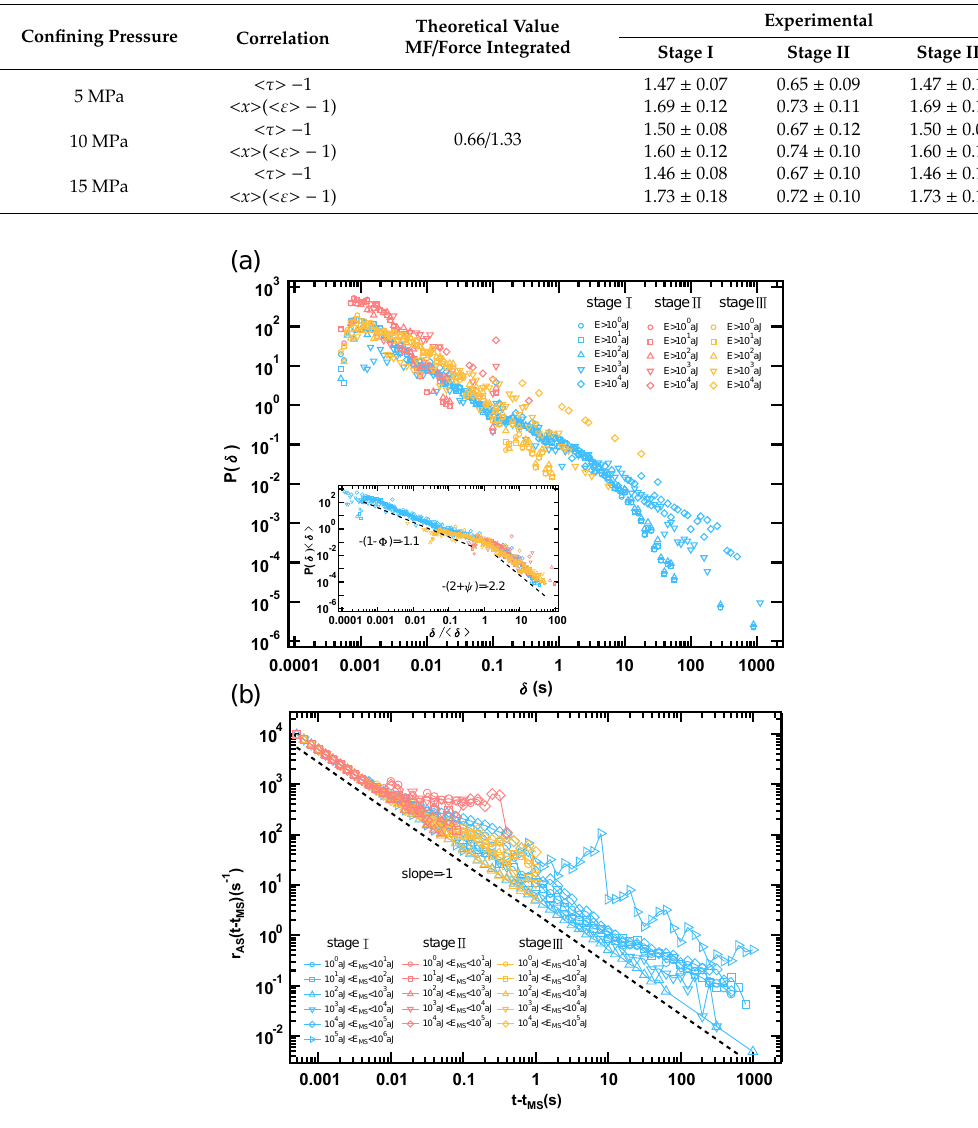
Figure 5. ( a ) Histogram distributions of waiting time for di ff erent stages with di ff erent energy thresholds. The inset shows the waiting time distribution after normalized by its average. ( b ) Rate of aftershocks per unit time, r , as a function of the time lapse to the main shock for di ff erent stages. The black dashed line indicates the Omori’s behavior with slope = −1.